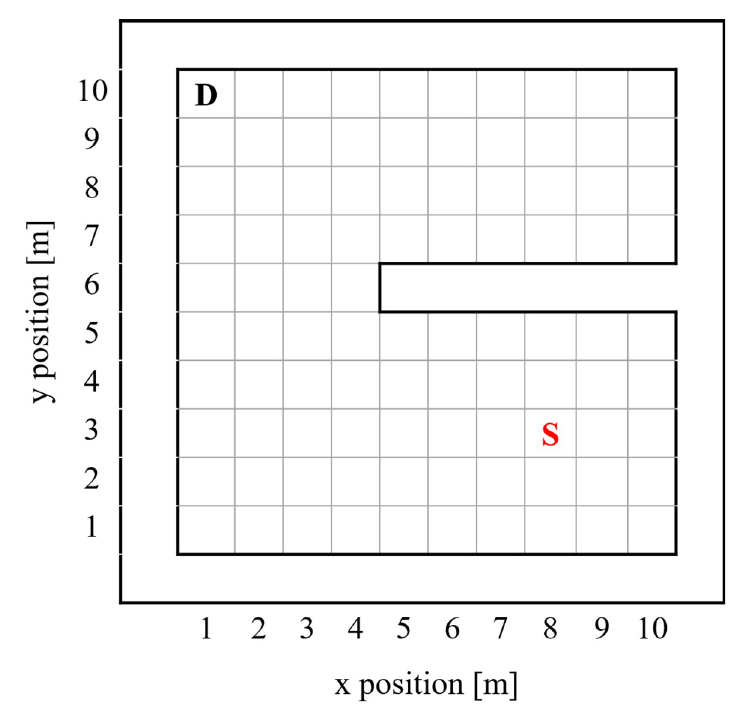
Fig 1. Simulated environment. Diagram of a possible configuration of the simulation environment with the detector- agent marked with the “D” and the source location marked with the “S”. A wall is seen protruding from the right side of the environment. Detector-agent location is restricted to the center of grid